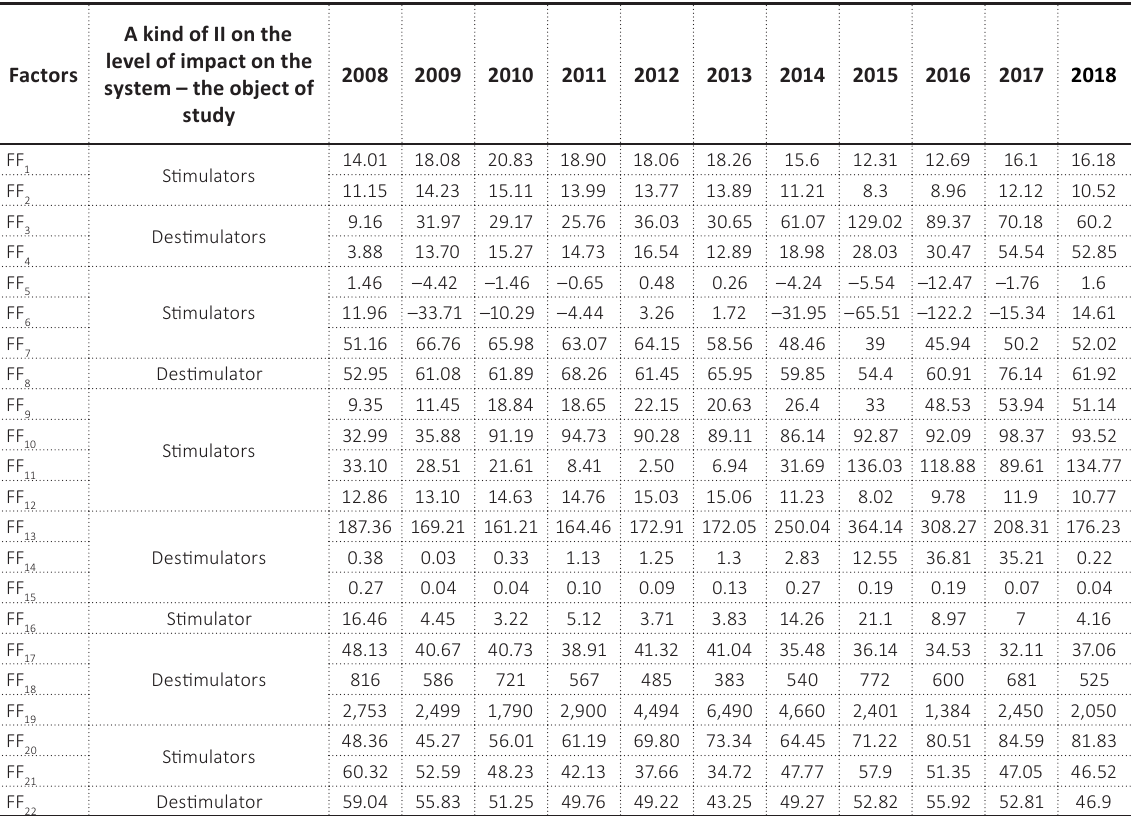
Table B2. System of indicators of the “Financial stability” component Source: Systematized according to the data from the National Bank of